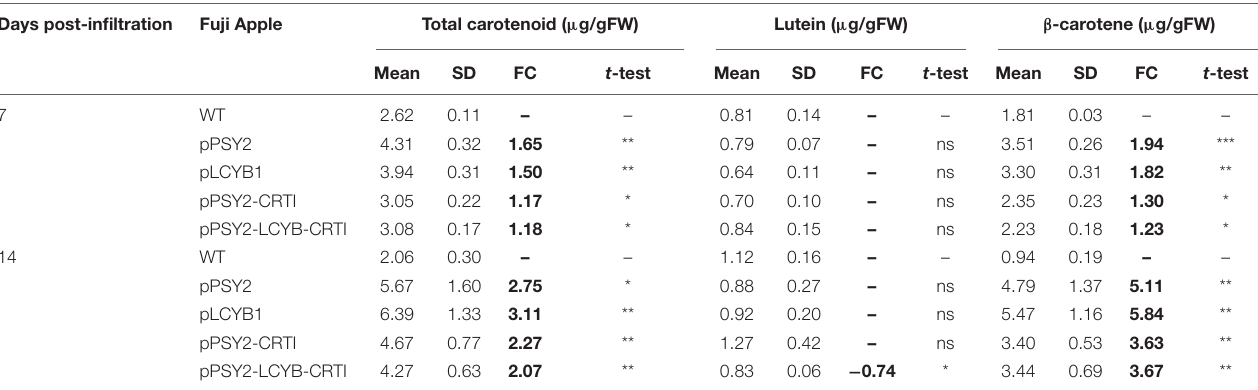
TABLE 1 | Quantification of carotenoids in apple fruits agroinfiltrated with the pCP-CG vectors. Days post-infiltration Fuji